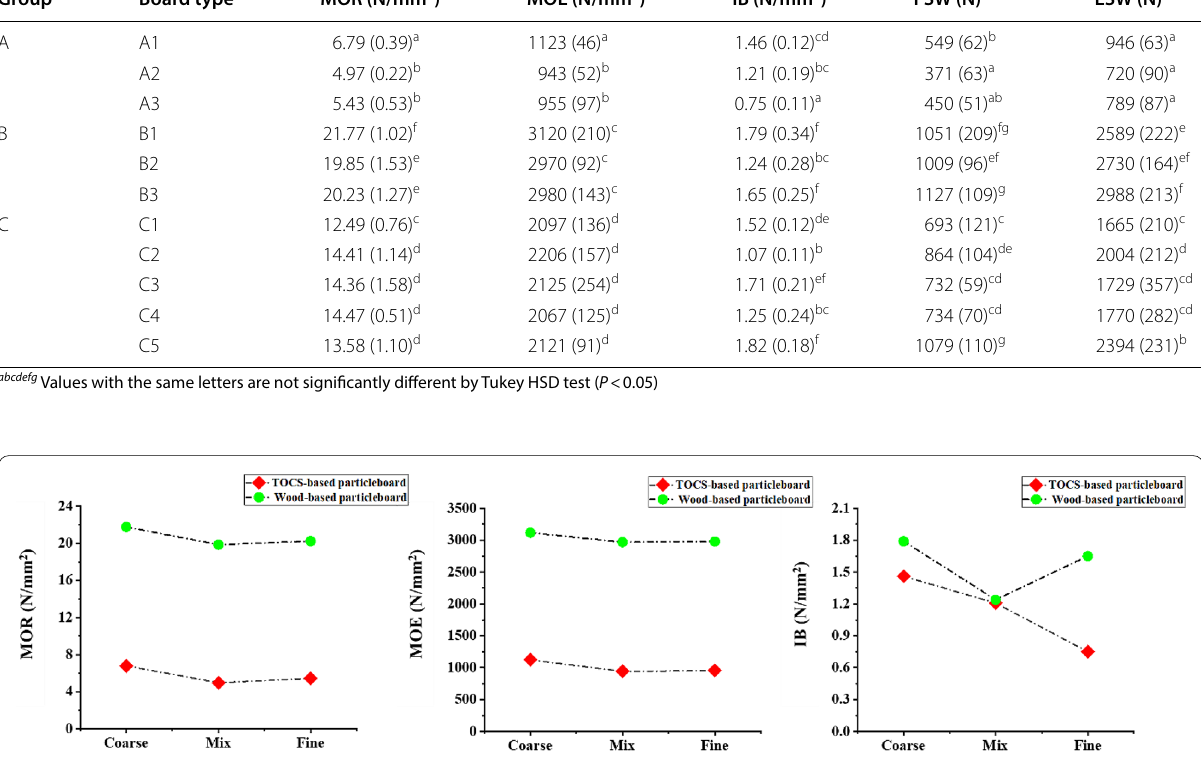
Table 5 Effect of particle size and combination on mechanical properties of single layer TOCS-based particleboard Group